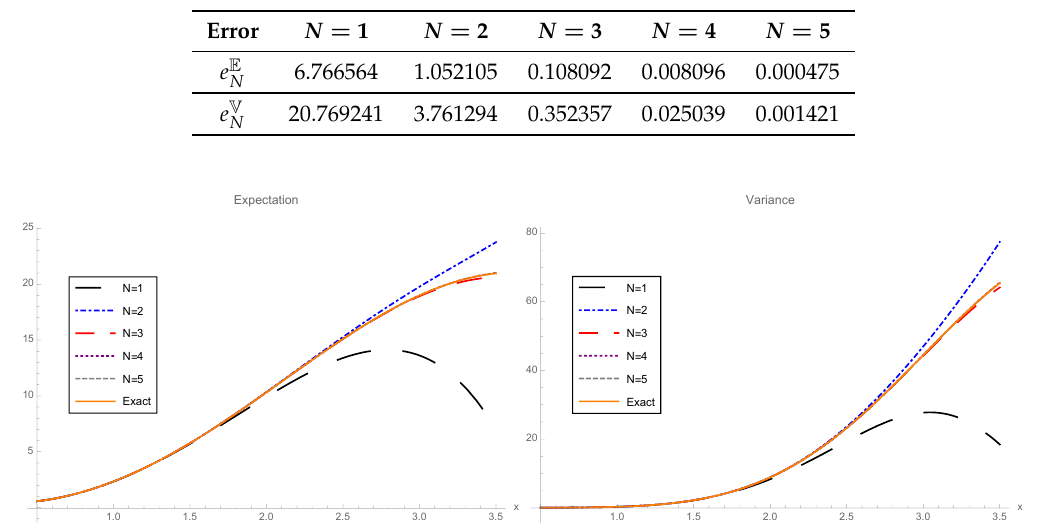
Figure 8. Left : Expectation of the solution to Problem (34) using different orders of truncation N ∈ { 1,2,3,4,5 } in the series (17). Right : Variance of the solution to Problem (34) using different orders of truncation N ∈ { 1,2,3,4,5 } in the series